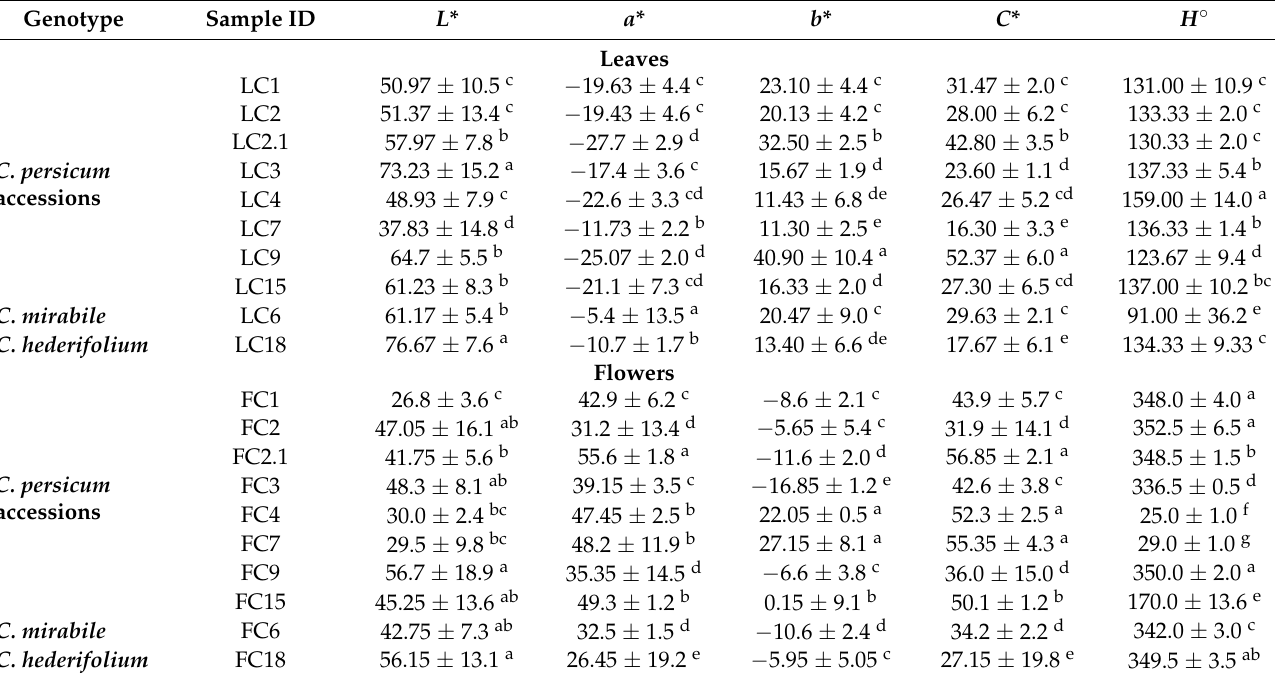
Table 1. Colorimetric data of Cyclamen genotypes’ leaves and